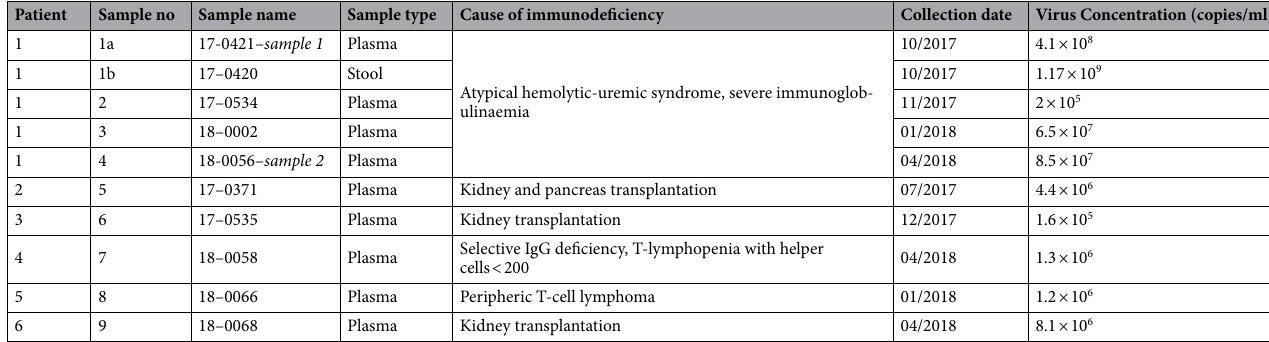
Table 1. Samples from patients with chronic HEV